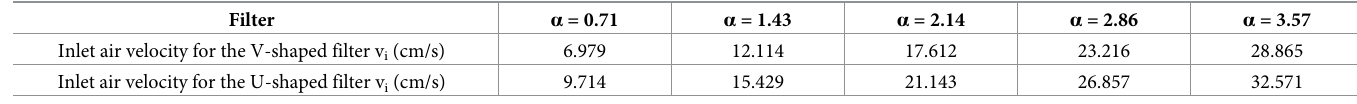
Table 3. Inlet air velocity under a filtration velocity of 4 cm/s.